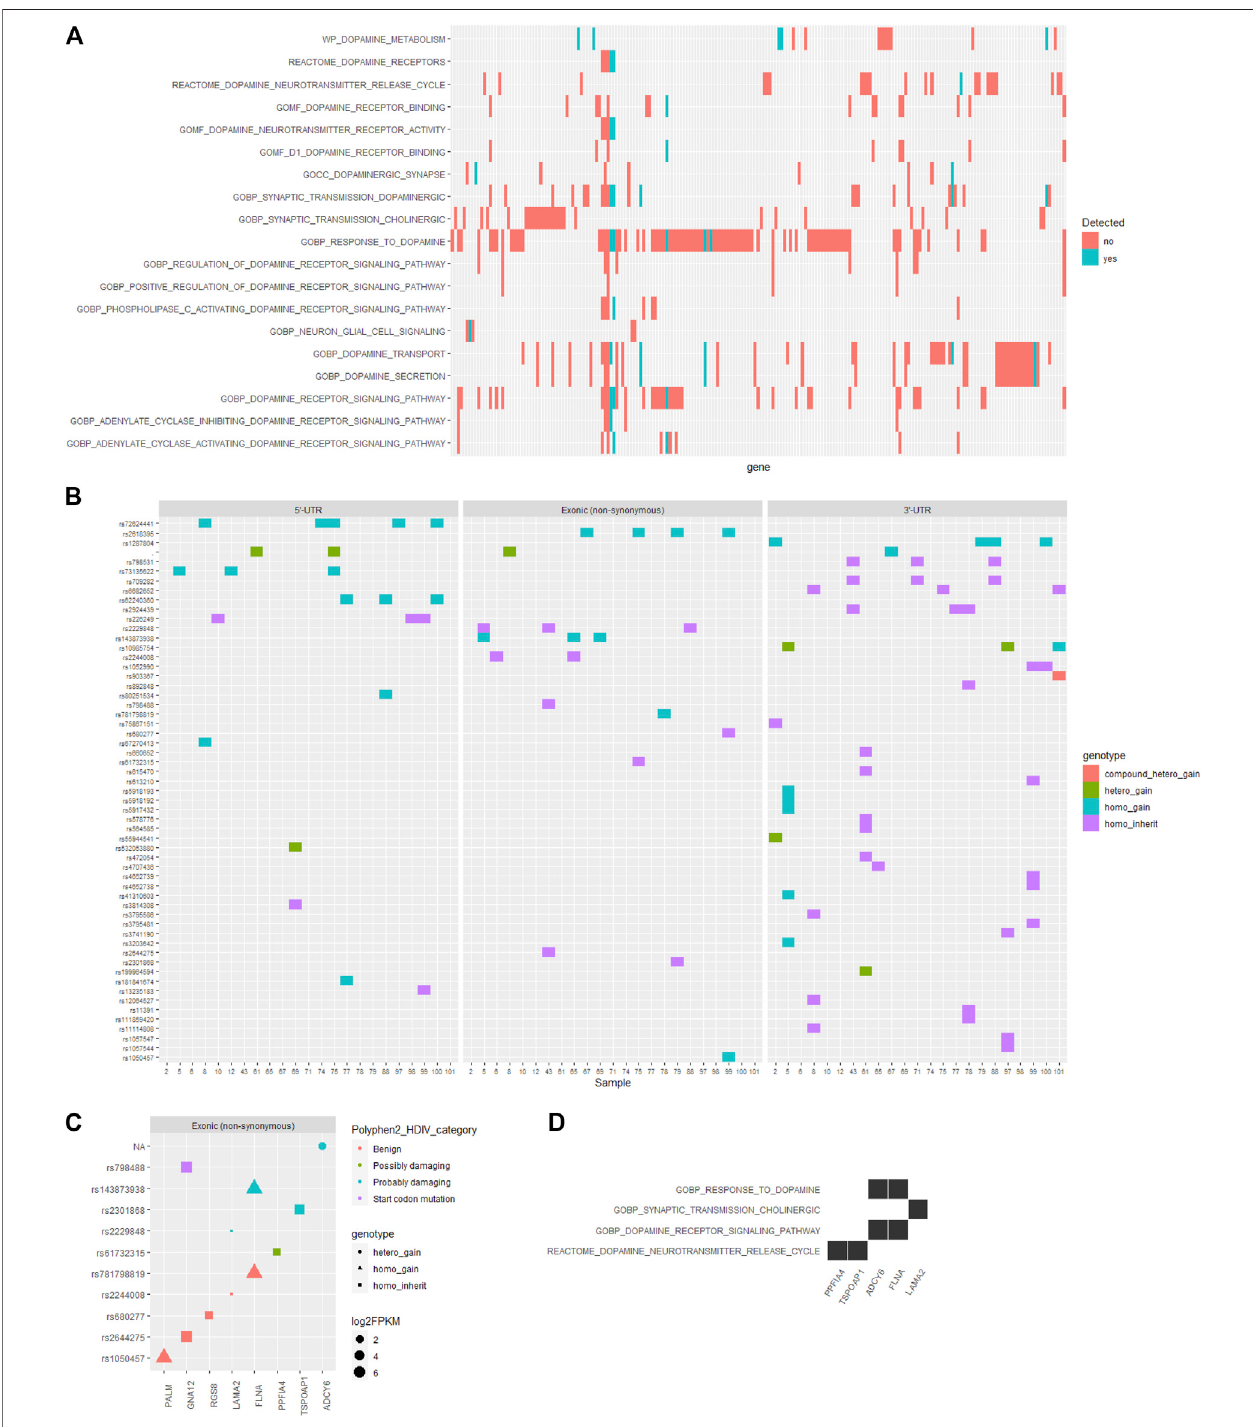
FIGURE 3 | Distribution and functional annotation of fi ltered SNVs in dopamine-related genes. (A) A heatmap showing the distribution of intersect genes on dopamine-related functions and in the reported ADHD-susceptible regions (colored in cyan). (B) Heatmaps showing the distribution of fi ltered SNVs locating in dopamine-relatedgenesinADHDchildrenandingenomicregionsincluding5 ′ -UTR,codingregion(exon),and3 ′ -UTR.Genotypecategoriesofeachsitewerelabeledin different colors as indicated in the legend. (C) A dot plot showing the information of fi ltered SNVs and their corresponding genes. SNV genotype and the in fl uence on protein functions, and gene expression level were marked by dot shape, color, and size, respectively. (D) A heat plot showing the distribution of certain genes corresponding to SNVs in coding regions on dopamine-related functions.